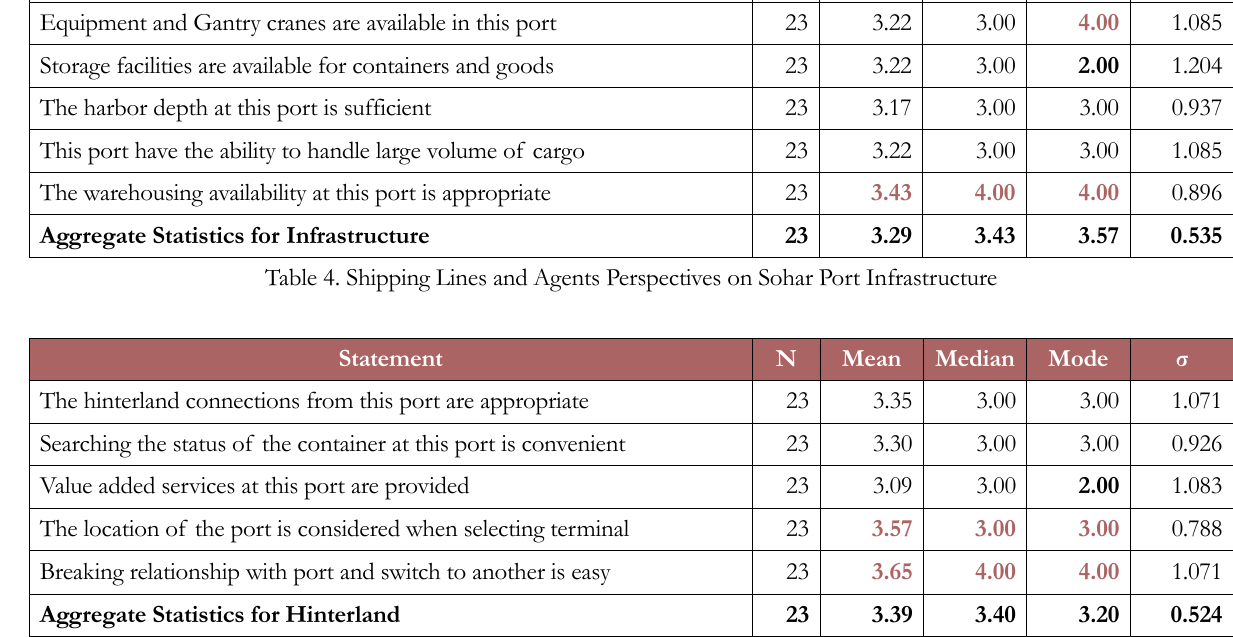
Table 5. Shipping Lines and Agents Perspectives on Sohar Port